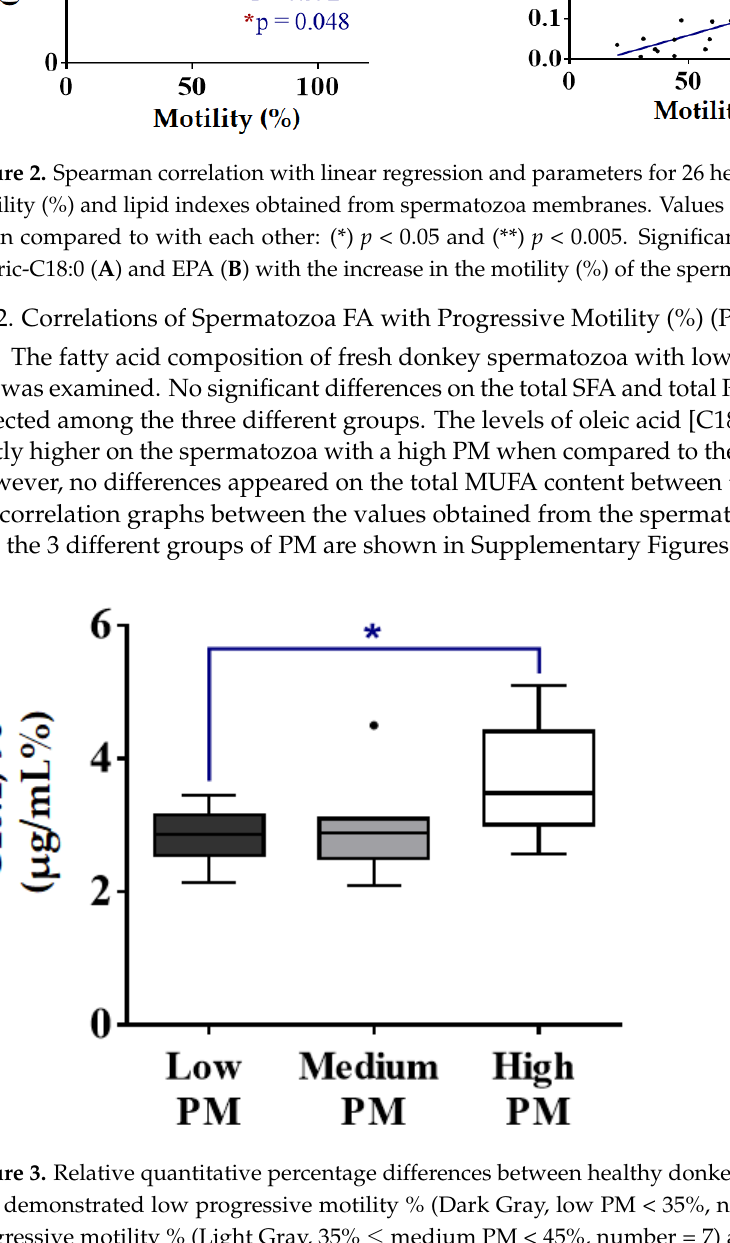
Table 4. Co hort of 12 Fatty Acids Expressed as Percentages of the Found μg/mL Quantities Detected by Gas Chromatographic Analyses of the Fatty Acid Methyl Esters (FAMEs) after Isolation and Workup Erythrocyte Membrane Glycerophospholipids of 26 Healthy Donkeys. FAME (%μg/mL)